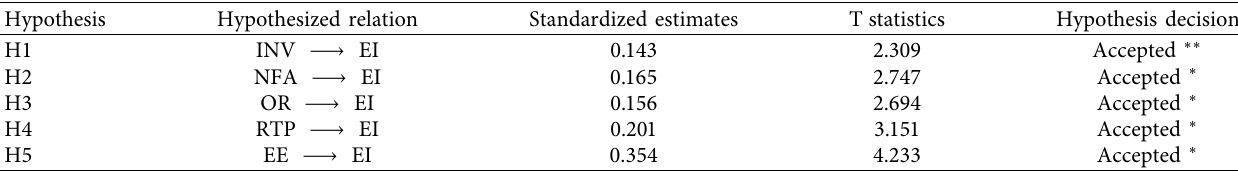
Table 7: Hypotheses testing of H1, H2, H3, H4, and H5.